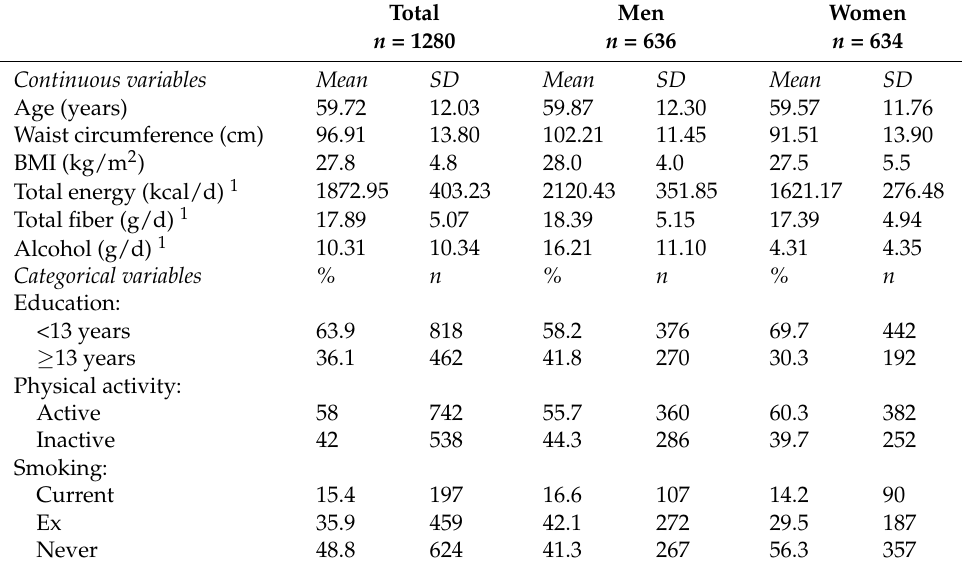
Table 1. Characteristics of the study population by